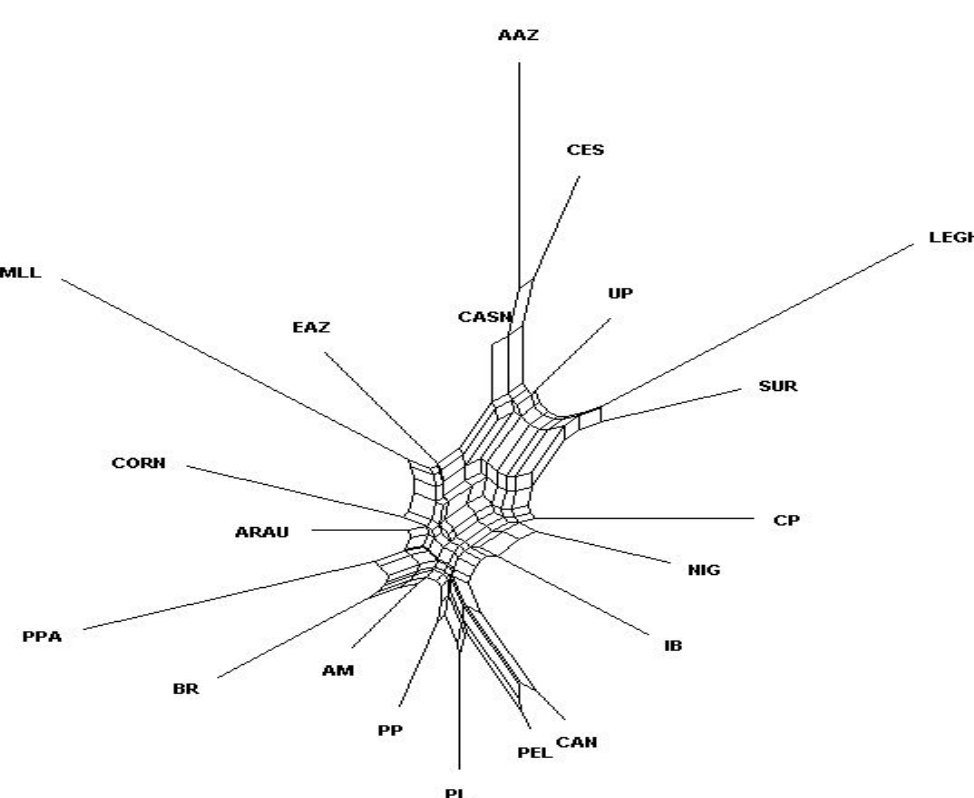
Figure 4. Neighbor-net constructed using the Nei’s genetic distance between the 20 breeds in study. CP, Canela-Preta; CAN, Caneluda do Catolé; PEL, Peloco; AAZ, Andaluza Azul; CASN, Castellana Negra; CES, Combatiente Español; EAZ, Extremeña Azul; IB, Ibicenca; MLL, Mallorquina; PPA, Pita Pinta; SUR, Sureña; UP, Utrerana Perdiz; ARAU, Araucana; NIG, Nigerian chicken; AM, Amarela; BR, Branca; PLU, Preta Lusitânica; PP, Pedrês Portuguesa; LEGH, Leghorn; CORN, Cornish.